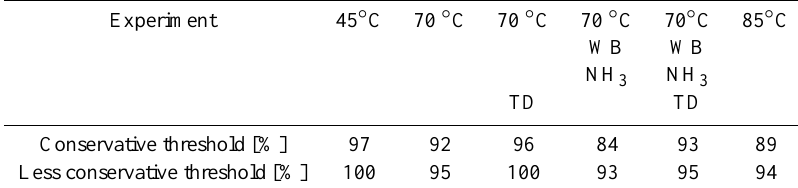
Table 1. Compilation of the percentage of particles showing a clear sulphate signal in the ATOFMS spectra after passing the sulphuric acid coating section. The temperature indicated is the temperature of the sulphuric acid coating bath. TD indicates the use of the thermodenuder which, if applied, was set to 250 ◦ C for all experiments. WB marks experiments with the water bath in use and NH 3 refers to experiments during which ammonia was added to the